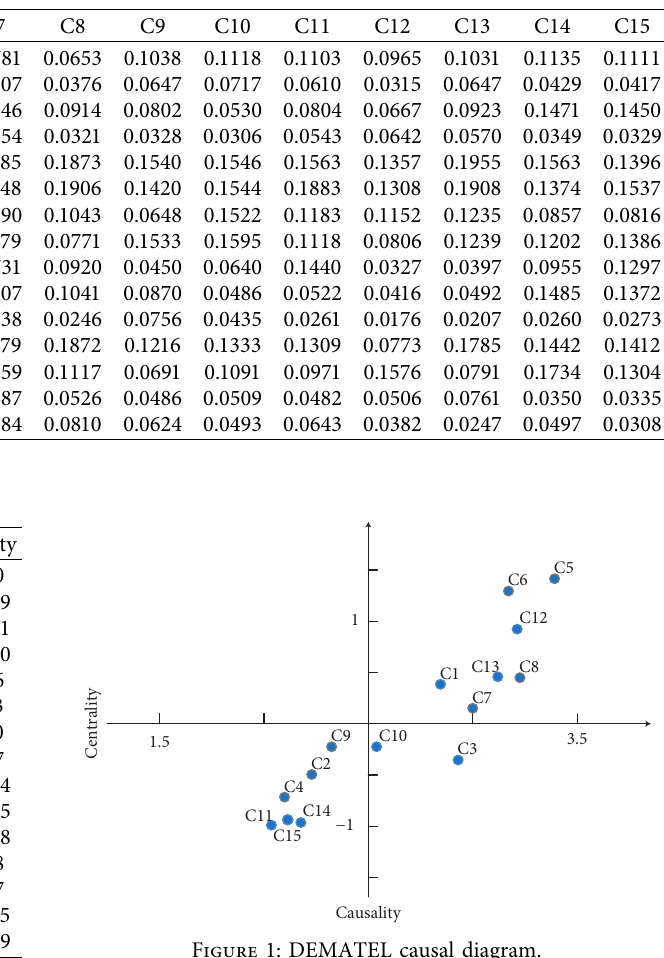
Table 4: The comprehensive impact matrix of blockchain technology on intelligent transportation.